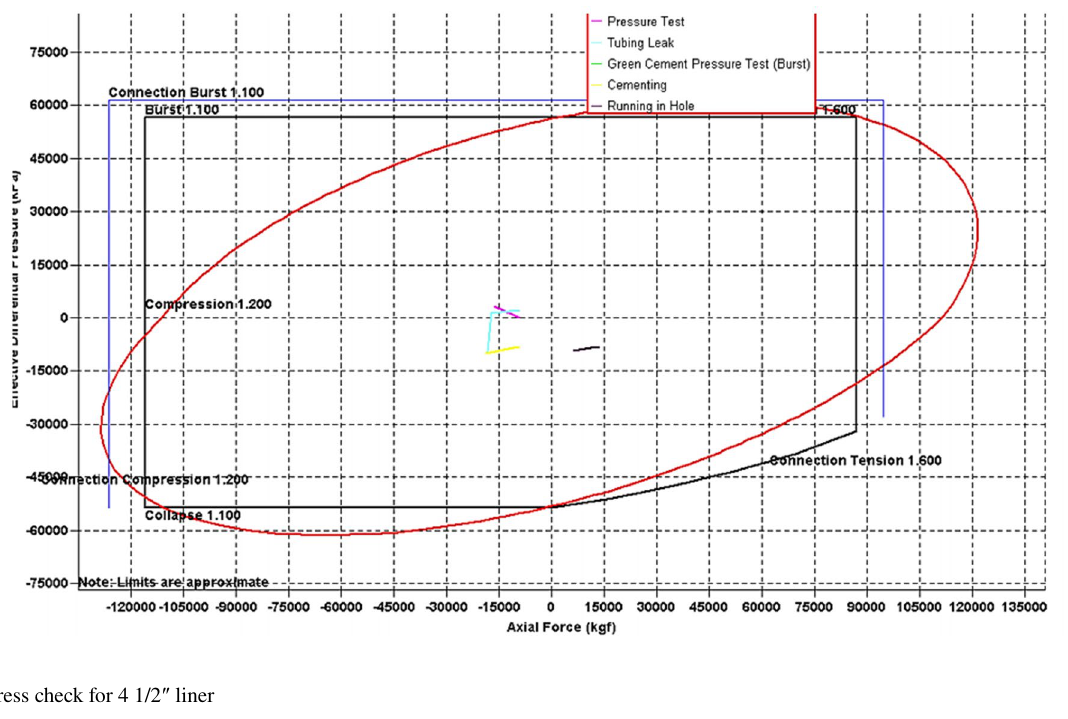
Fig. 3 Stress check for 4 1/2 ″ liner